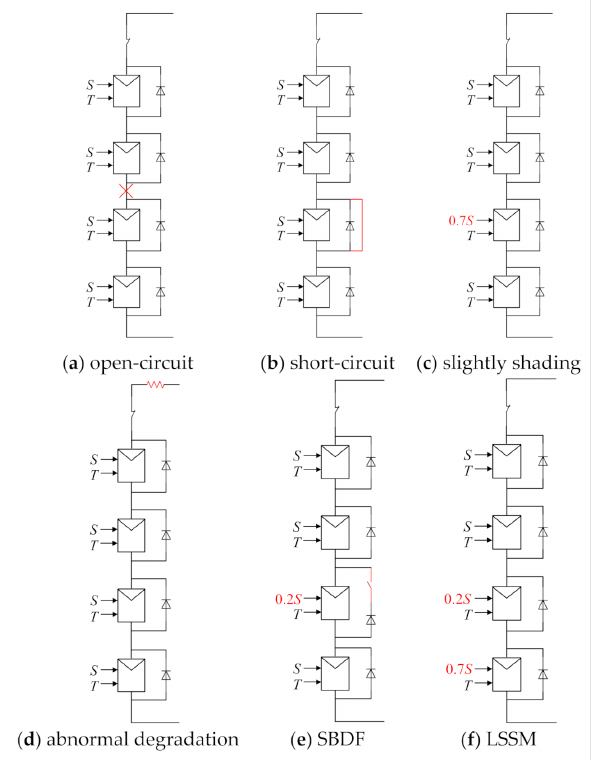
Figure 10. Simulation models for different